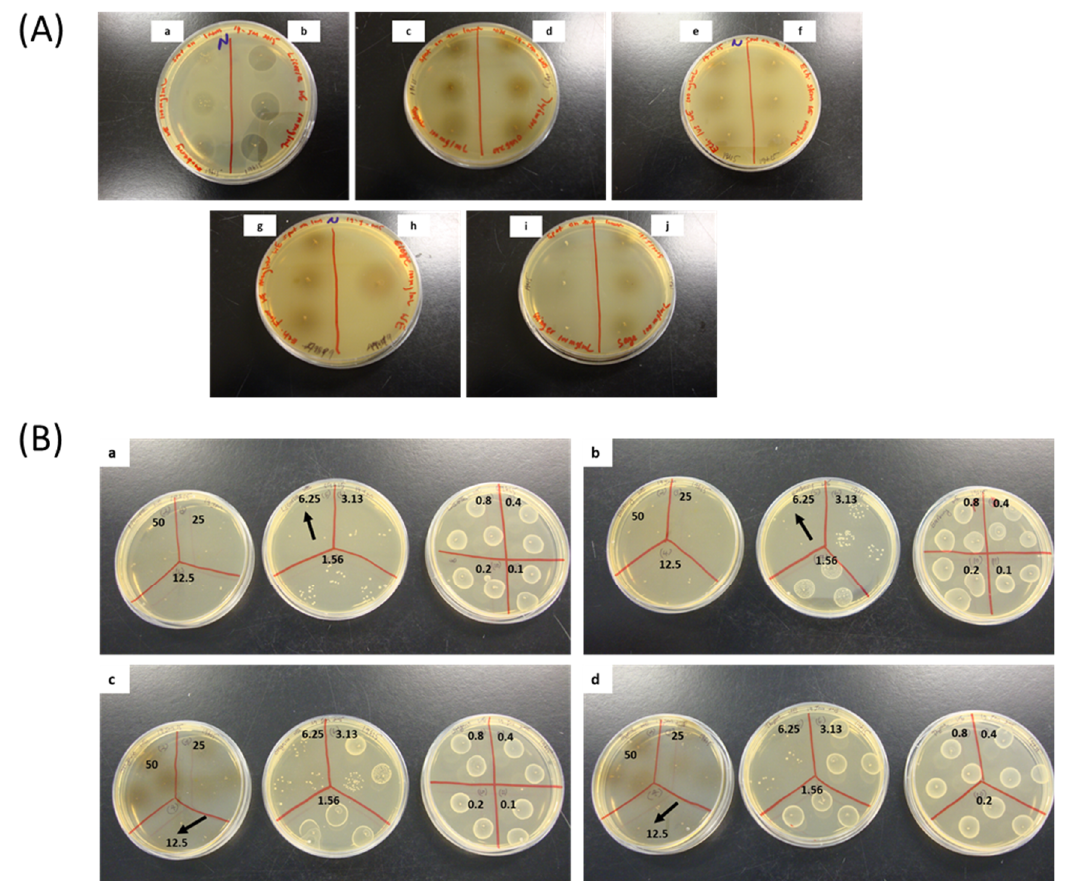
Figure 2. ( A ) Antibacterial effect of HWIs (100 mg/mL) spotted on brain heart infusion (BHI) agar plates inoculated with the Streptococcus pyogenes ATCC 19615. HWIs: Hot water infusions; a: